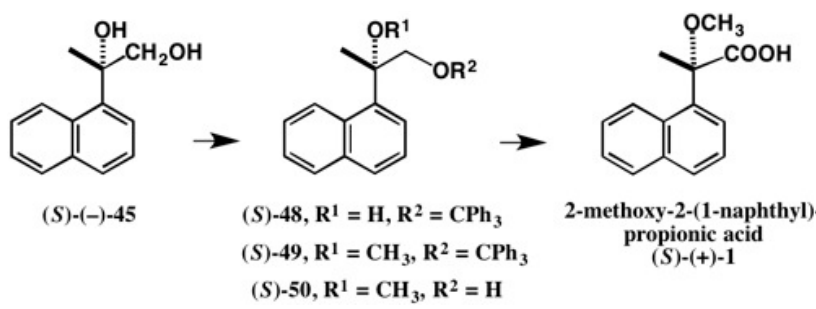
Figure 33. Conversion of diol ( S )-( − )- 45 to 2-methoxy-2-(1-naphthyl)propionic acid ( S )-(+)- 1 .